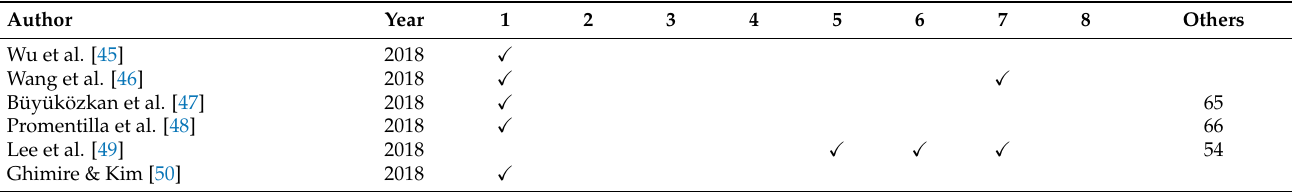
Table 1. Distribution of decision approaches in CES study